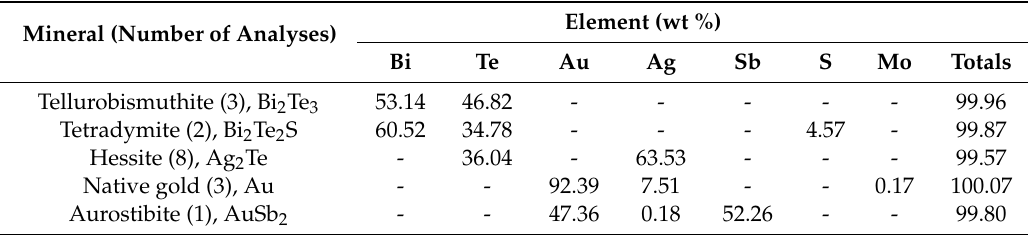
Table 7. Chemical composition of Au and Te minerals from sphalerite-wurtzite-chalcopyrite-isocubanite breccias with opal